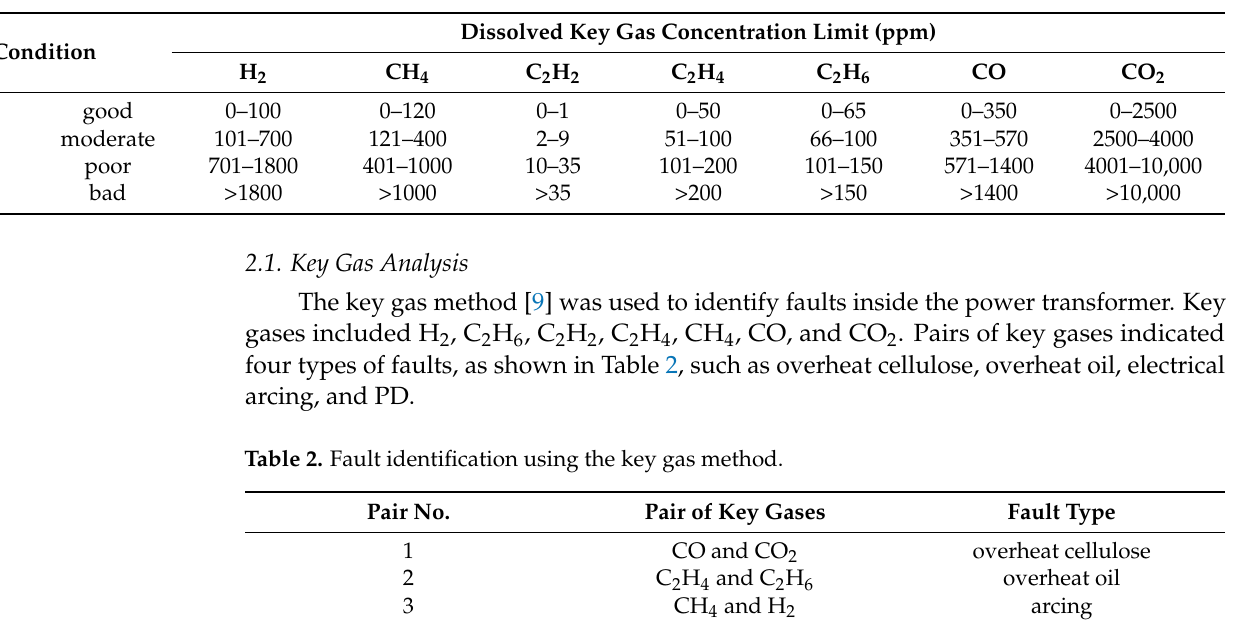
Table 1. Dissolved key gas concentration and condition classification.